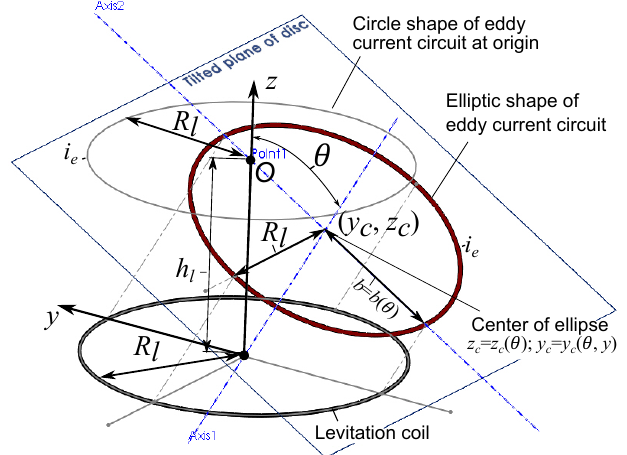
Figure 3. Reduced scheme for modeling electromagnetic interaction between the levitation coil and the tilt-disc: h l is the levitation height between a plane of coils and equilibrium point; θ is the tilting angle; i e is the induced eddy current corresponding to the maximum current density within the disc; R l is the radius of the levitation coil; z c = z c ( θ ) and y c = y c ( θ , z c ) are the coordinates of the center of the ellipse as functions of generalized coordinates; b = b ( θ ) is the length of minor axis of the